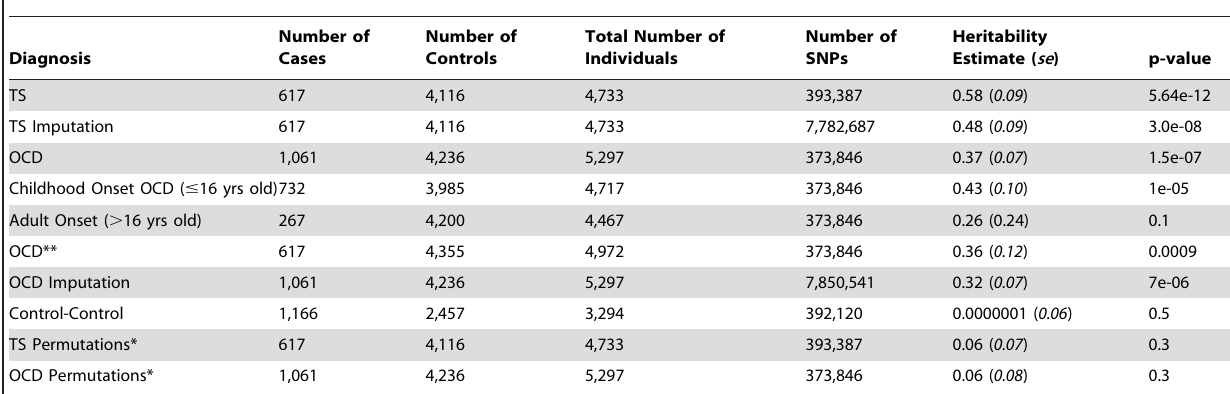
Table 1. Overall heritability analysis of obsessive-compulsive disorder and Tourette